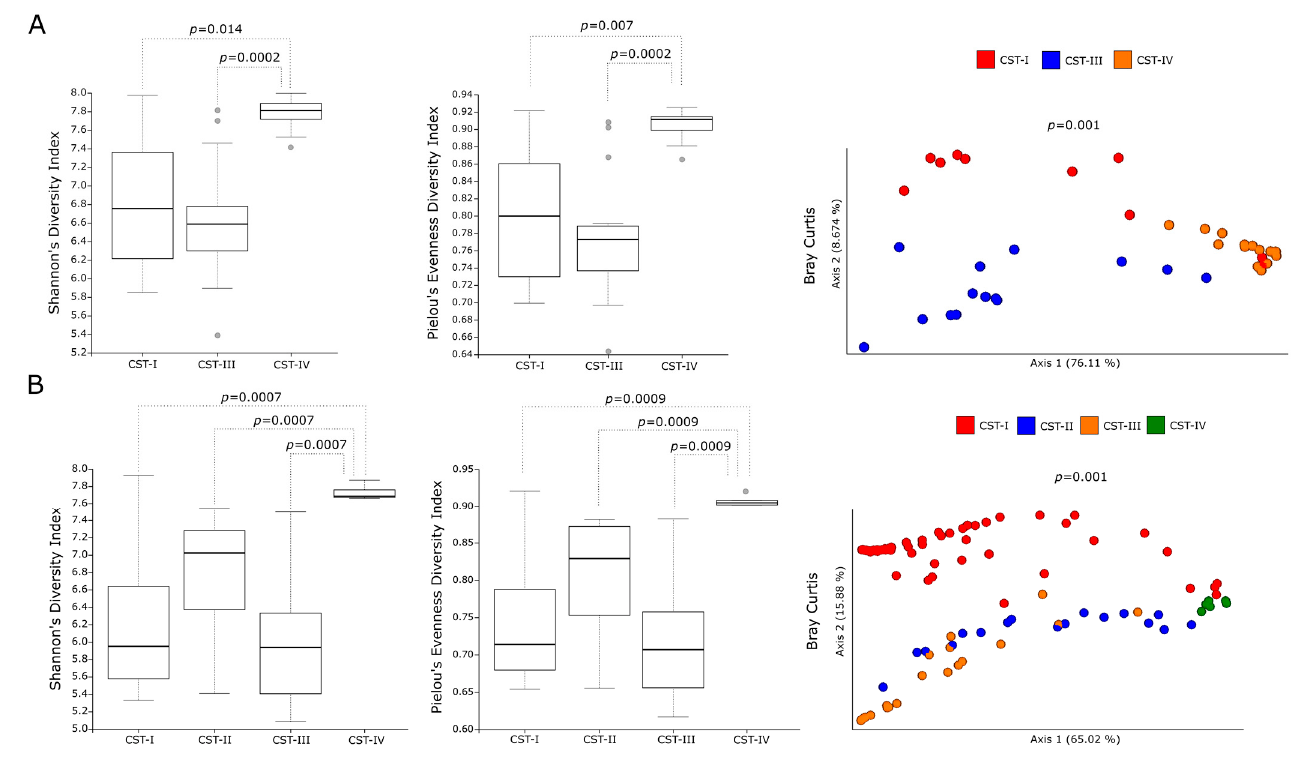
Figure 2. Alpha- and beta-diversity indexes of the predicted metabolic pathways in the different CSTs. Shannon’s, Pielou’s evenness, and Bray-Curtis indexes of the metabolic pathways in the different CSTs in ( A ) C. trachomatis -positive women; ( B ) healthy controls. The gray circles in the boxplots represent the outliers; each colored circle represents the predicted metabolic pathways in the cervicovaginal microbiota of each study subject.